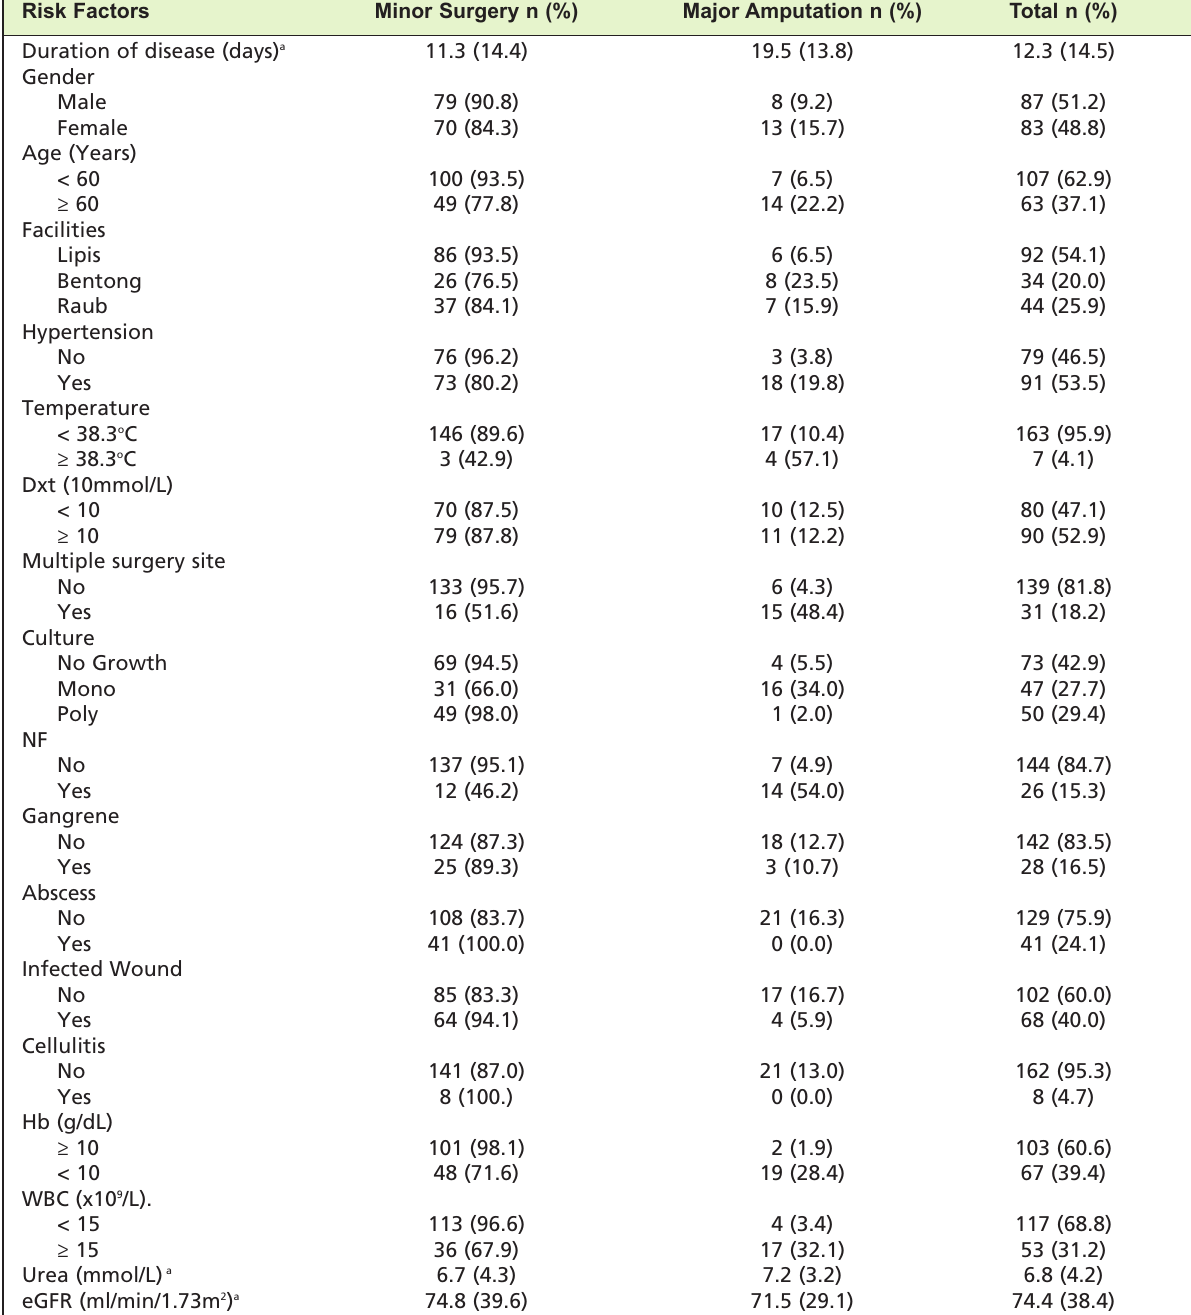
Descriptive statistics for potential risk factors for major outcome Table I: